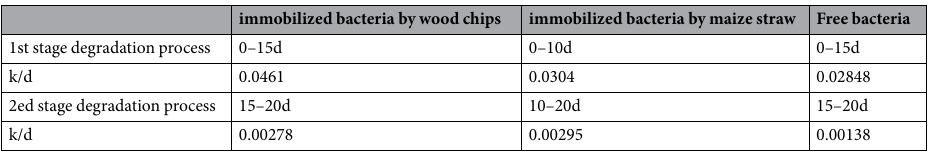
Table 2. Degradation efficiency percentage (%) and